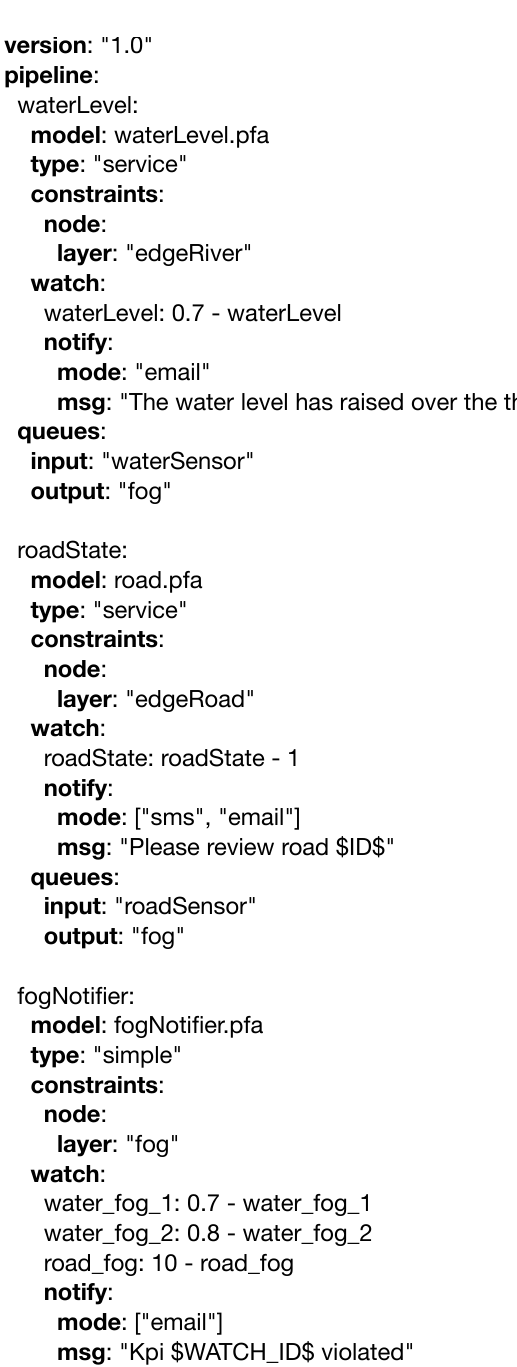
Figure 22. PADL document definition for the flood control usecase for the edge and fog computing